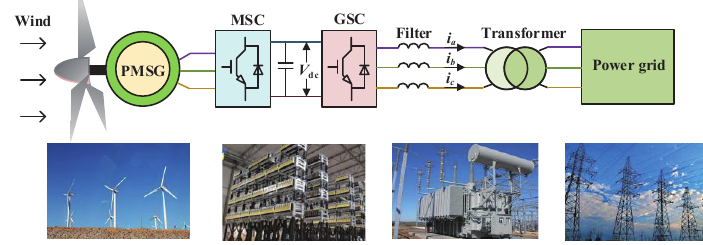
Figure 1. Configuration of a PMSG-WT based